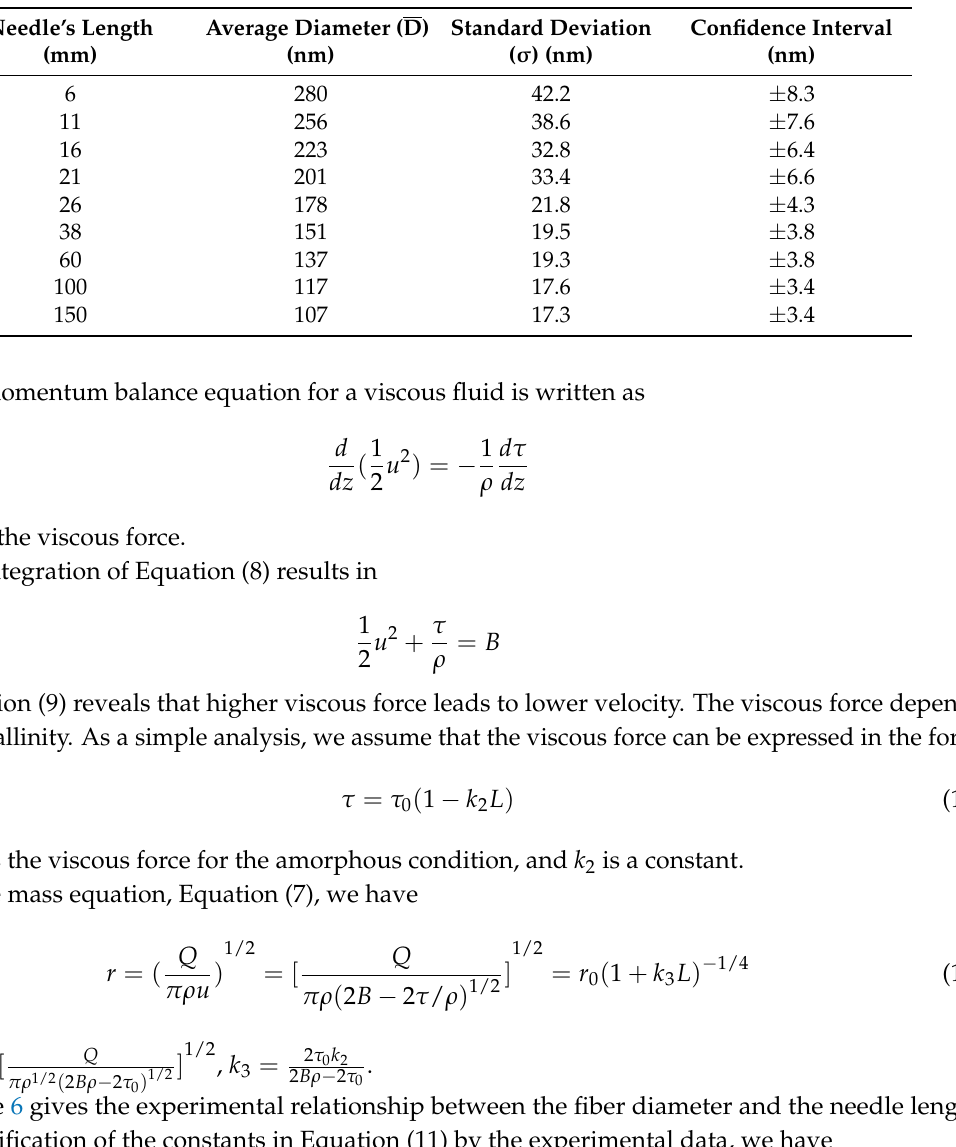
Table 2. The relationship between needle length and the average diameter of